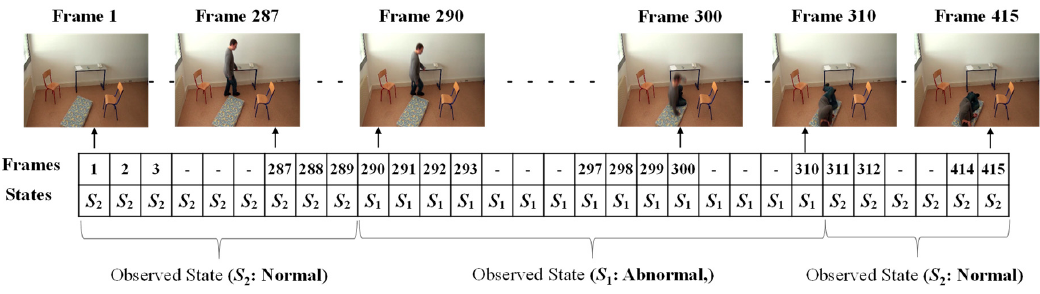
Figure 13. Observations of the occurrences of states for Mr. ONE (Video 1).